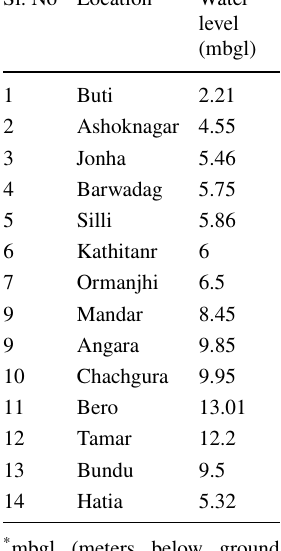
Table 8 Selected wells